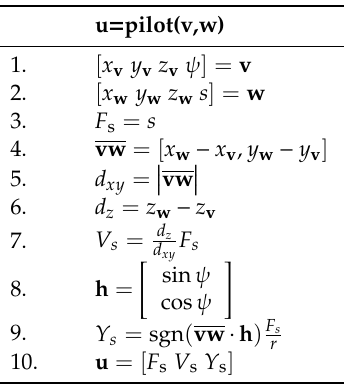
Table 1. Pilot’s algorithm.